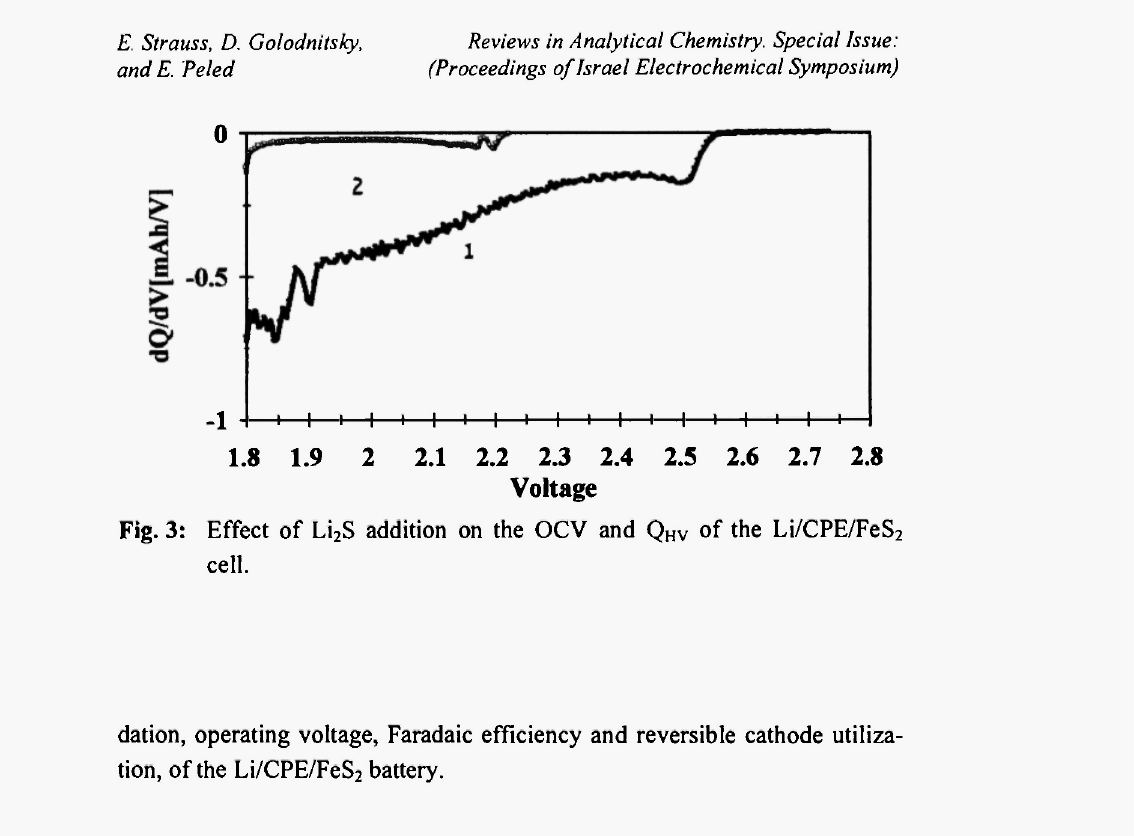
Fig. 3: Effect of Li 2 S addition on the OCV and Q HV of the Li/CPE/FeS 2